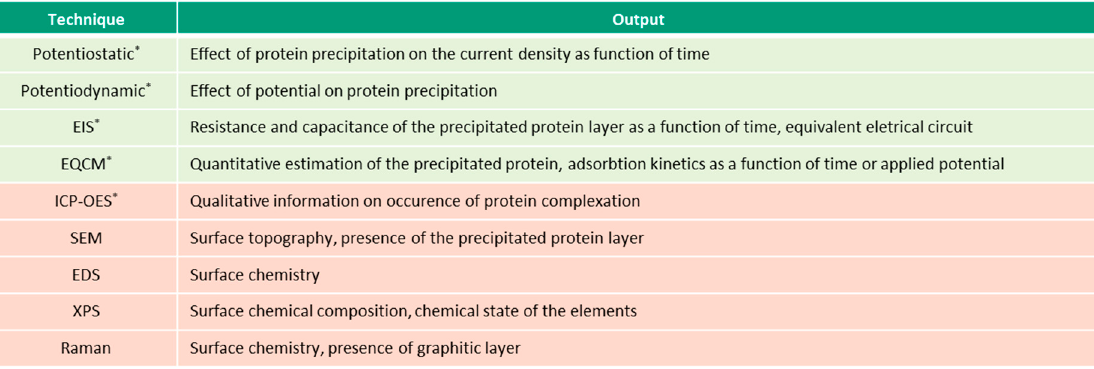
Figure 5. Techniques (in green—electrochemical, in-red—microscopic and spectroscopic) used for investigation of albumin precipitation (* in-situ techniques).